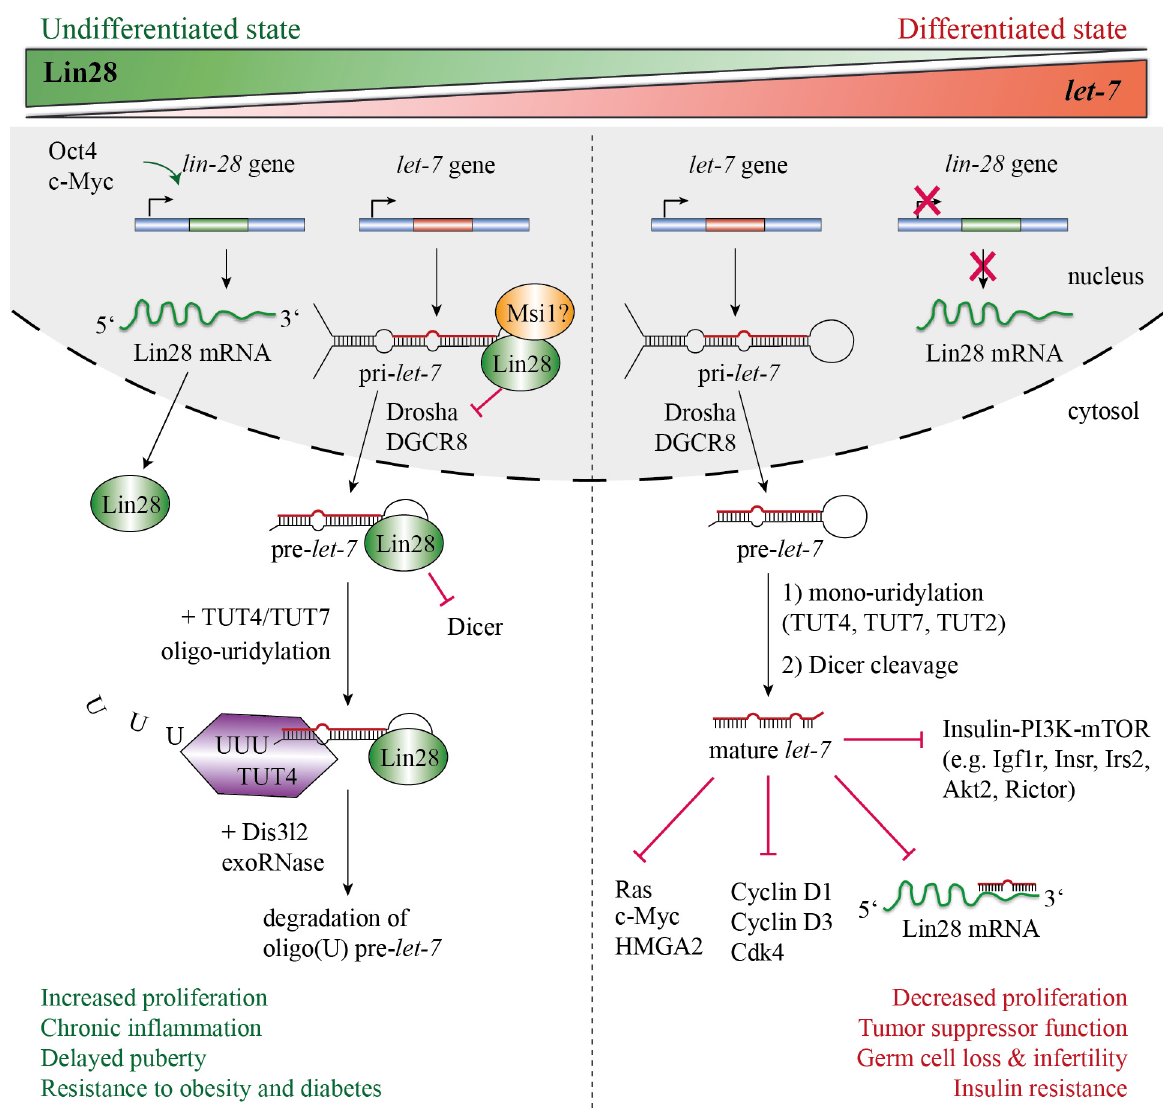
upon differentiation of stem or progenitor cells, let-7 ensures constant down-regulation of Lin28 by binding to the 3' UTR of Lin28 and its promoting transcription factor c-Myc [20] (Figure 2). Figure 2. Lin28/ let-7 regulatory axis. In undifferentiated cells, Lin28 is highly expressed and blocks the biogenesis of let-7 miRNA. By binding to the pre-element of pri- or pre- let-7 , neither Drosha nor Dicer can process the corresponding let-7 precursor. In addition, Lin28 recruits TUT4/TUT7 to pre- let-7 and promotes its 3'-end oligo-uridylation. Oligo-uridylated pre- let-7 cannot be cleaved by Dicer and thus serves as a signal for the cellular 3'–5' exoribonuclease Dis3l2. Upon differentiation, Lin28 expression is reduced, which leads to increased levels of mature let-7 . The latter silences gene expression of proto-oncogenes (Ras, c-Myc, Hmga2), cell cycle progression factors (Cyclin D1 and D3, Cdk4), components of the insulin-PI3K-mTOR pathway and Lin28 itself, thereby establishing a positive feedback loop. Besides its role in differentiation, a Lin28/ let-7 regulatory network is apparently involved in several cellular processes such as proliferation, oncogenesis, development and physiology, as well as metabolism (recently reviewed in